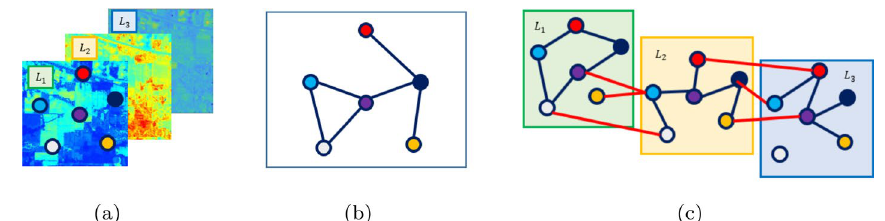
Fig. 1 Examples of graph models for HSI: a Stack of 3-band images in Indian Pines where six pixels/ superpixels are selected as examples of nodes; b A single-layer graph model for the 3-band HSI in ( a ) based on feature similarity; c Example of a multilayer graph model with 3